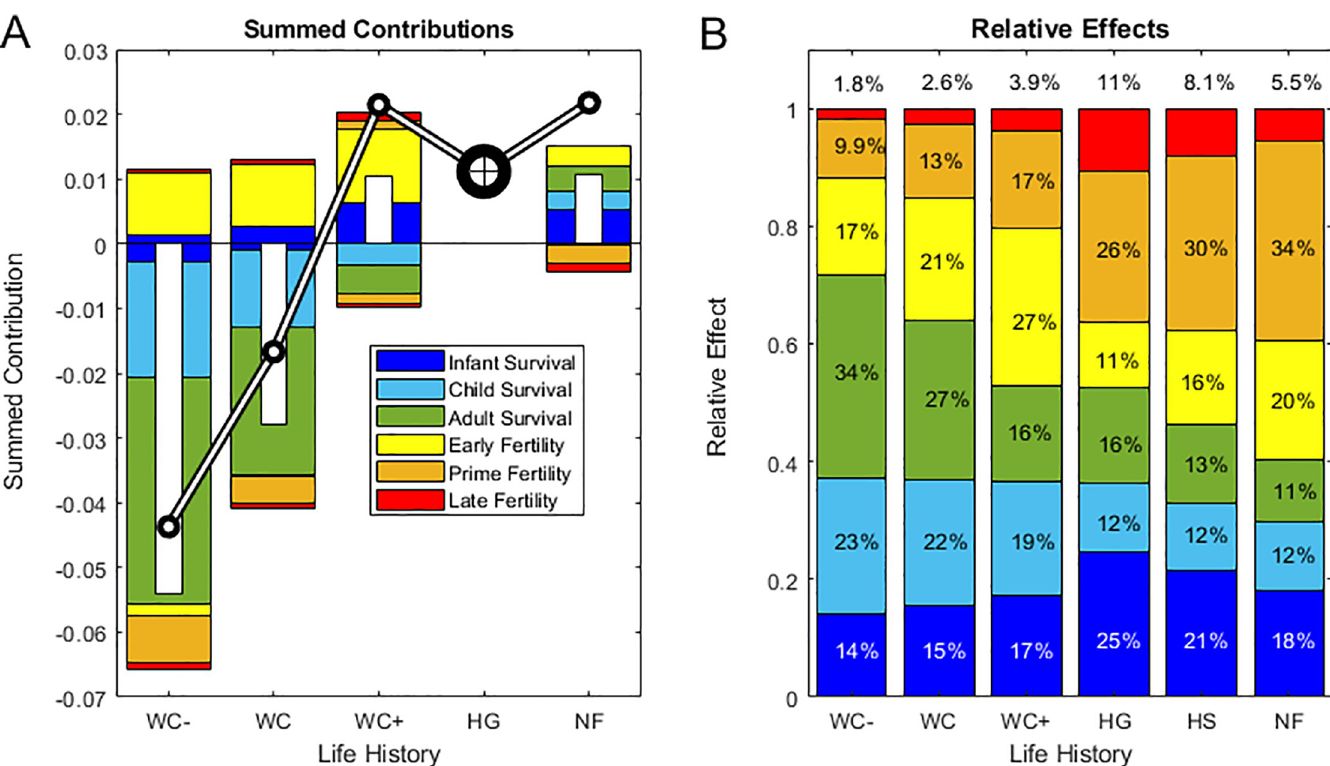
Fig 5. Summed contributions for each composite life history. (A), stacked bars show summed contributions of infant, child and adult survival and of early, prime and late fertility to the net difference ( Δ r ) in population growth rate (inset white bars) between the composite mean hunter-gatherer reference (HG) and each focal population, with the black-and-white line crossing the bars indicating the focal population growth rate ( r = log( λ )). Note that positive and negative contributions are summed separately above and below the horizontal line at zero, and thus may reflect opposing contributions from the same life cycle component (e.g., negative and positive contributions of early vs. late infant mortality, respectively, if Δ p 0 < 0 and Δ p 1 > 0). Results are shown for four composite life histories with vital rates averaged over: declining chimpanzees (WC-), all wild chimpanzees (WC), increasing chimpanzees (WC+), hunter-gatherers (HG), or non-foragers (NF). HG (indicated by a bullseye) has zero contributions by definition because it is the common reference. (B), total effects ( S C ij � ) reflecting the combined magnitude of contributions, are averaged across the populations within each of the groupings in (A) plus averaged across all human groups (HS), in contrast to the results for the pre-averaged mean life histories shown in (A). Stacked bars decompose the mean total effect (the proportion of the combined magnitude of all contributions) made by infant, child and adult survival and by early, prime and late fertility (inset text shows the percent of total effects, with late fertility effects labeled above the